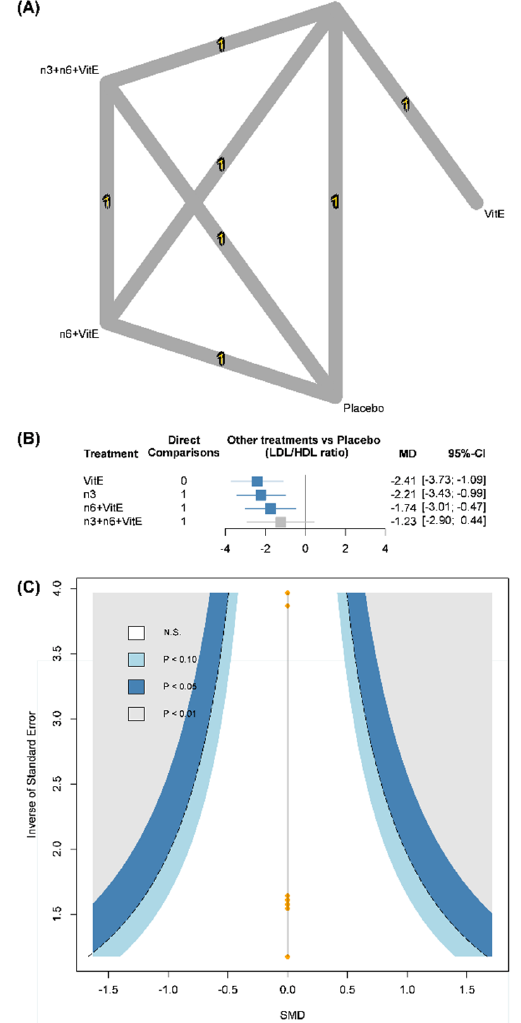
Figure 3. ( A ) Network plots of low-density lipoprotein to high-density lipoprotein ratio, ( B ) forest plot of low-density lipoprotein to high-density lipoprotein ratio, ( C ) comparison-adjusted funnel plot of low-density lipoprotein to high-density lipoprotein ratio. CI, confidence interval; MCTs, me- dium chain triglycerides; n3, omega-3 fatty acids; n6, omega-6 fatty acids; MD, mean difference; Vit E, vitamin